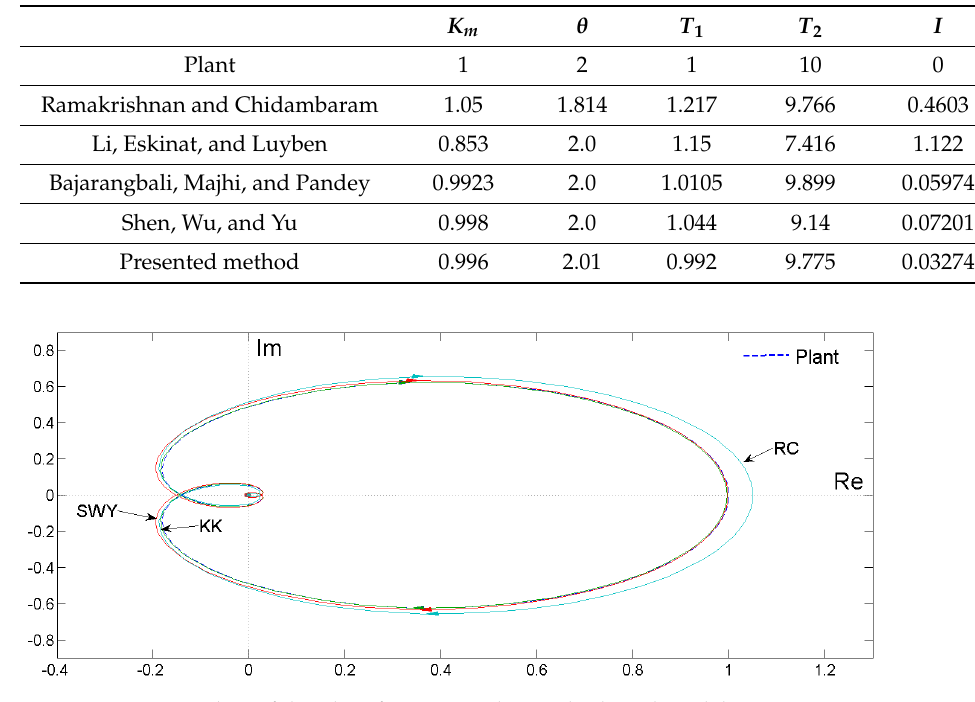
Figure 7. Nyquist plots of the plant from example 2 and selected models.